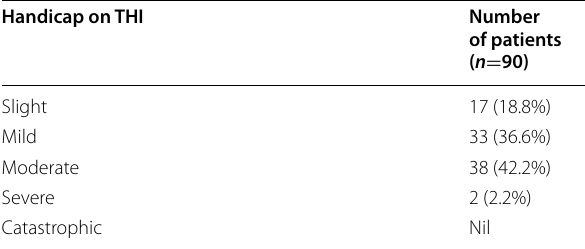
Table 2 Distribution of patients according to Tinnitus Handicap Inventory